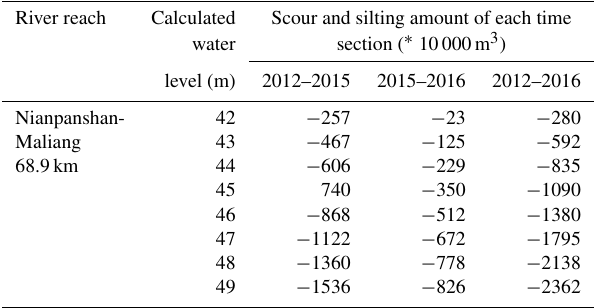
Table 1. Statistics of scour and silting amount in the Nianpanshan– Maliang reach riverbed ( + silting, − scour).